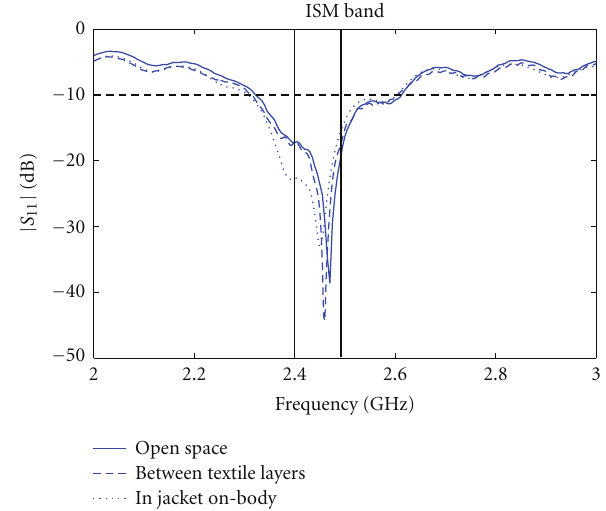
Figure 18: Measured reflection coe ffi cients in three di ff erent situations: array in open space (full line), array placed between textile layers (dashed line), and array placed on-body in a firefighter jacket (dotted line).